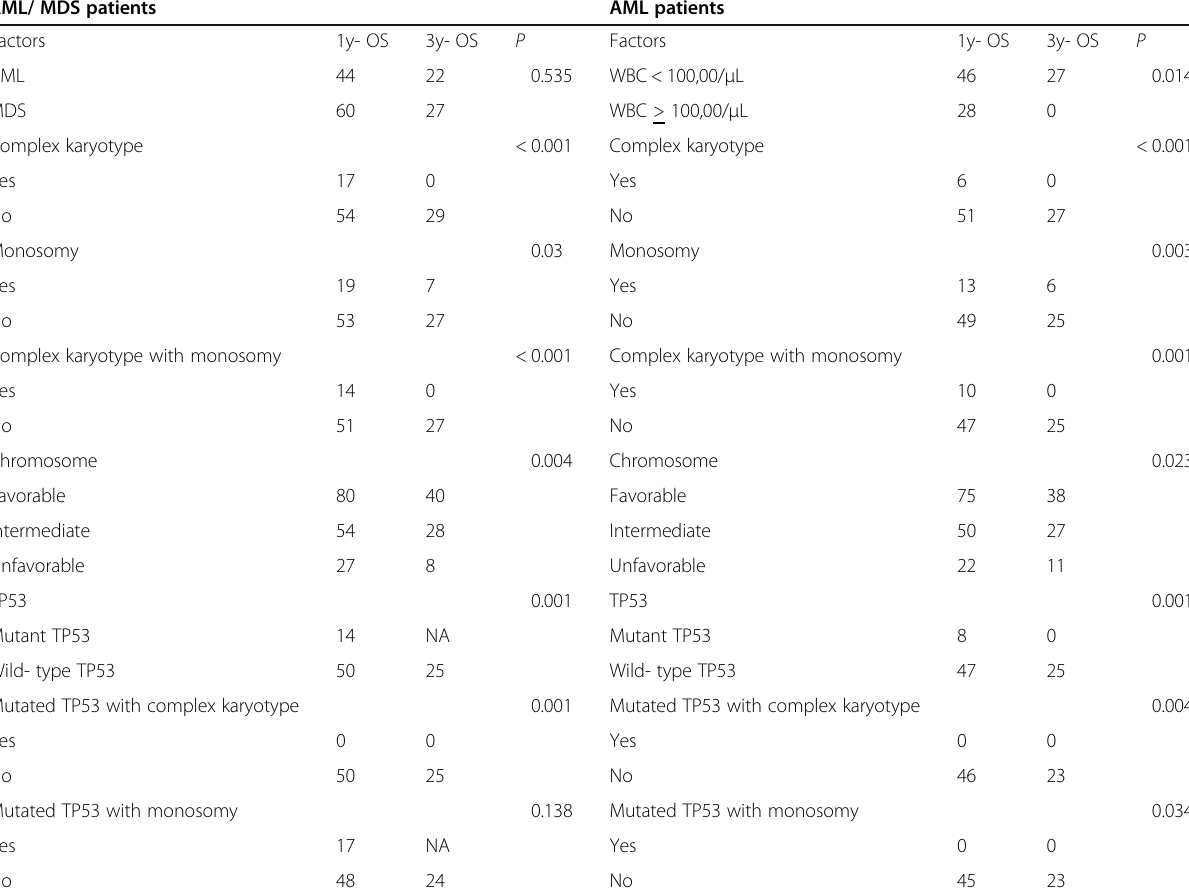
Table 3 Parameters affecting overall survival in 132 patients with AML/MDS AML/ MDS